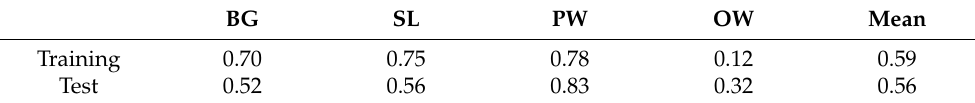
Table 8. IoU scores for the respective Soybeans